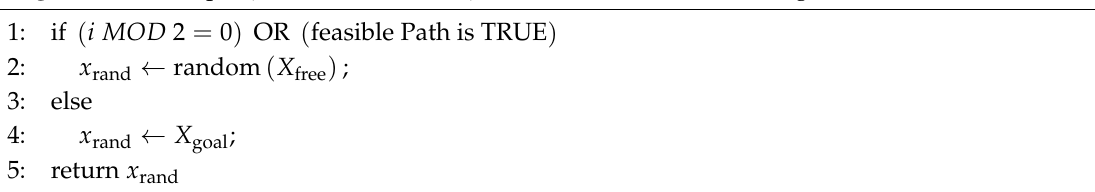
Algorithm 5: Sample ( i , feasiblePath, X free ) function of the RRT* Goal algorithm